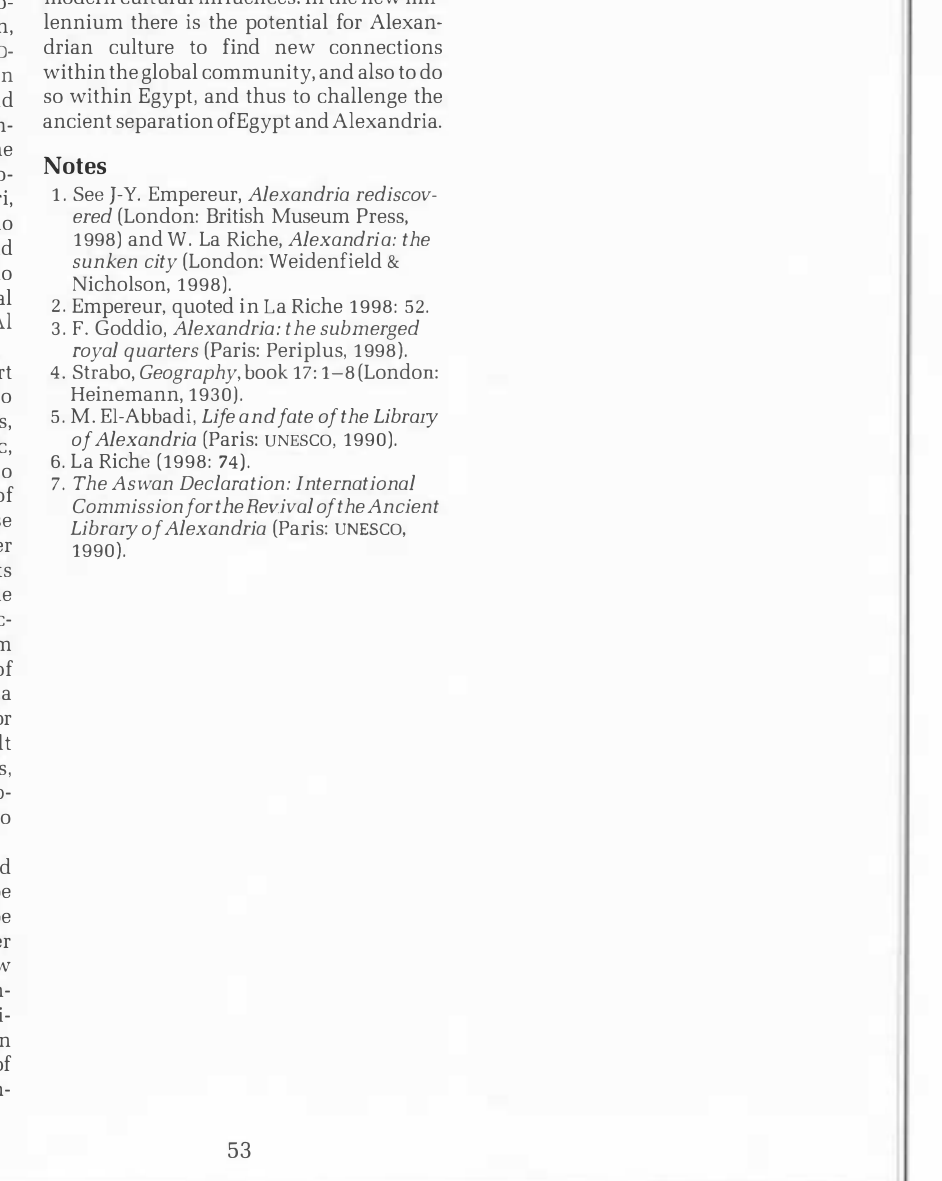
Rethinking Alexandrian and Egyp­ tian